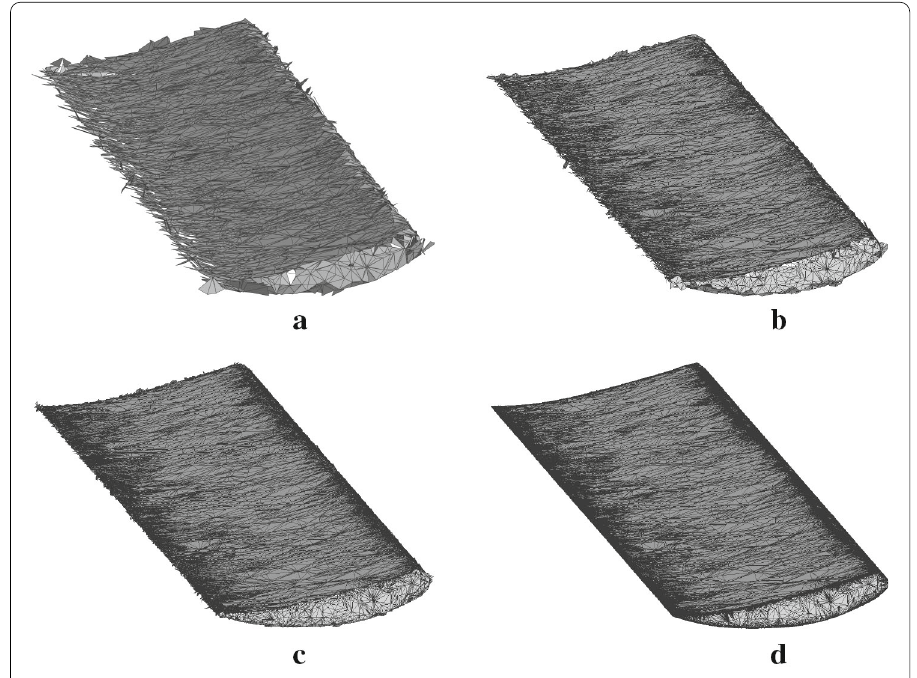
Fig. 25 Approximation of an immersed wing geometry within a background mesh after different levels of refinement. a No refinement (4 . 0e5 elements). b 1 level of refinement (4 . 4e5 elements). c 3 levels of